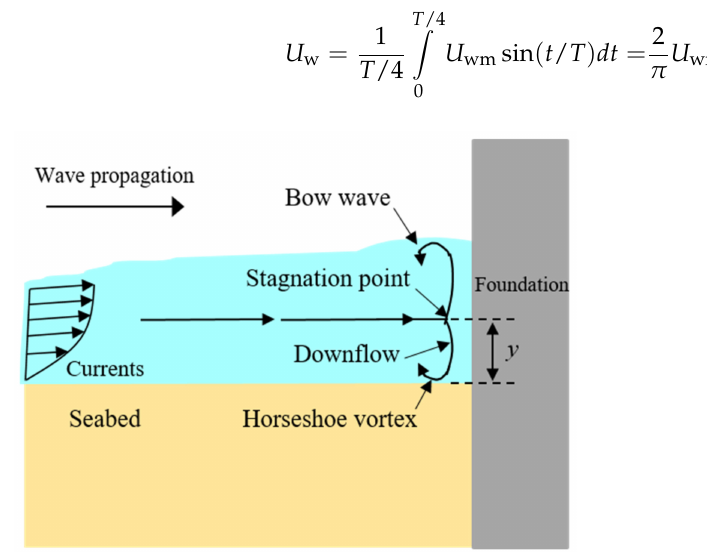
Figure 22. Sketch of flow field at upstream USAF edges. Tavouktsoglou et al. [25] proposed the following formula between F r and the vertical location of the stagnation y